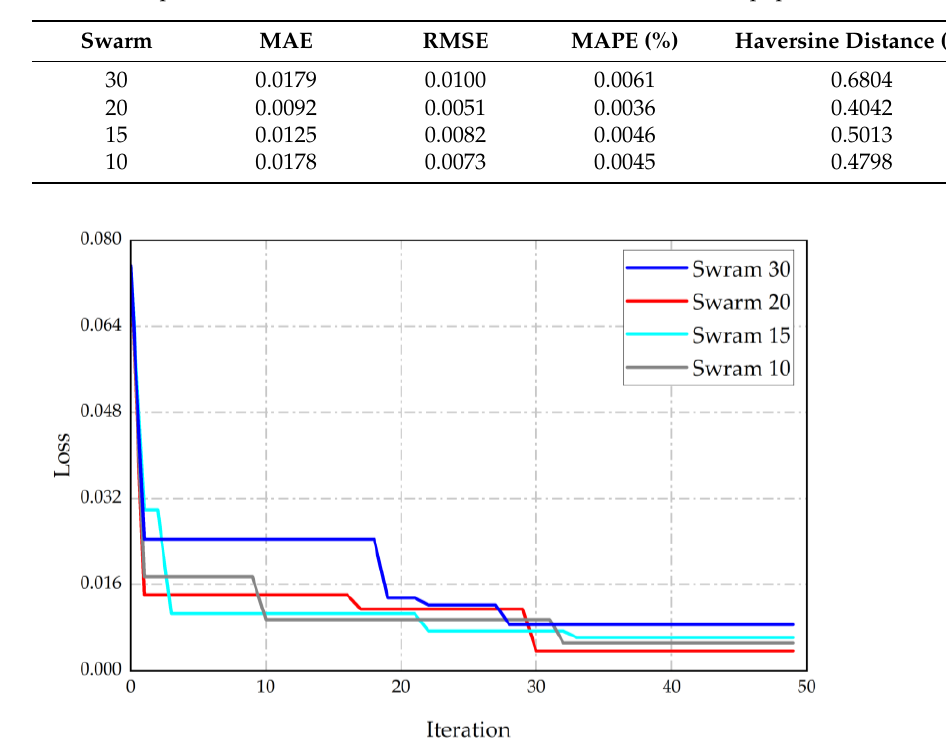
Table 3. The performance of the WOA-Attention-BILSTM with different population sizes.